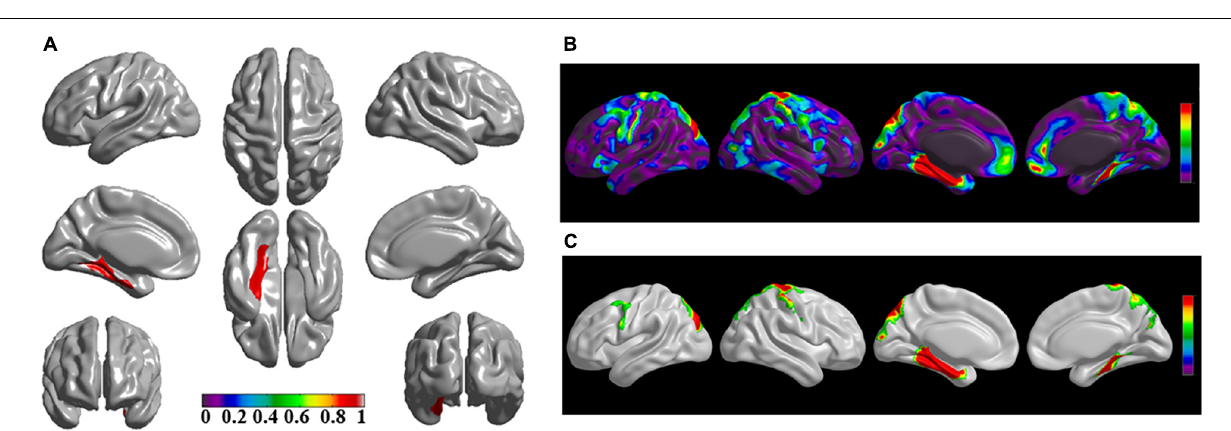
FIGURE 6 | The significantly altered brain regions of cortical structural connectivity in the sPD brain based on seed 6. (A) The brain regions of seed 6, the red brain regions represent the cortical thickness thinning regions. (B) The significantly altered brain regions in the F-map based on seed 6, the red, and green brain regions represent the brain regions of significant cortical structural connectivity alteration that were not corrected by the FWE. (C) The significantly altered brain regions after FWE correction based on seed 6, the red and green brain regions represent the brain regions of significant cortical structural connectivity alteration that were corrected by the